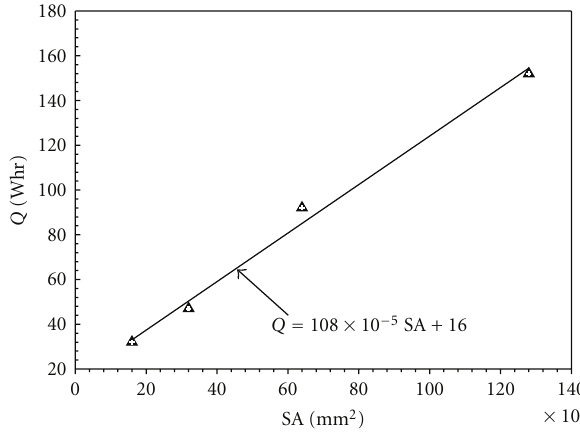
Figure 4: Energy consumption, Q , versus surface area, SA, of the model